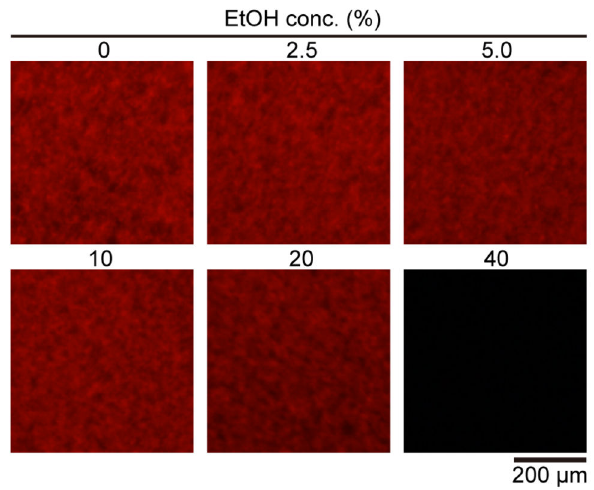
Figure 2. Effect of EtOH on Aβ aggregation. 30 nM QDAβ 42 and 30 µM Aβ were mixed in 1xPBS, 3% DMSO containing 0, 42 2.5, 5, 10, 20, or 40% EtOH, each sample was incubated at 37 ° C for 24 h in a 1536-well plate. The wells were observed using an inverted fluorescence microscope using a 4x objective. The images show 200 × 200 pixels in the center of each well. doi: